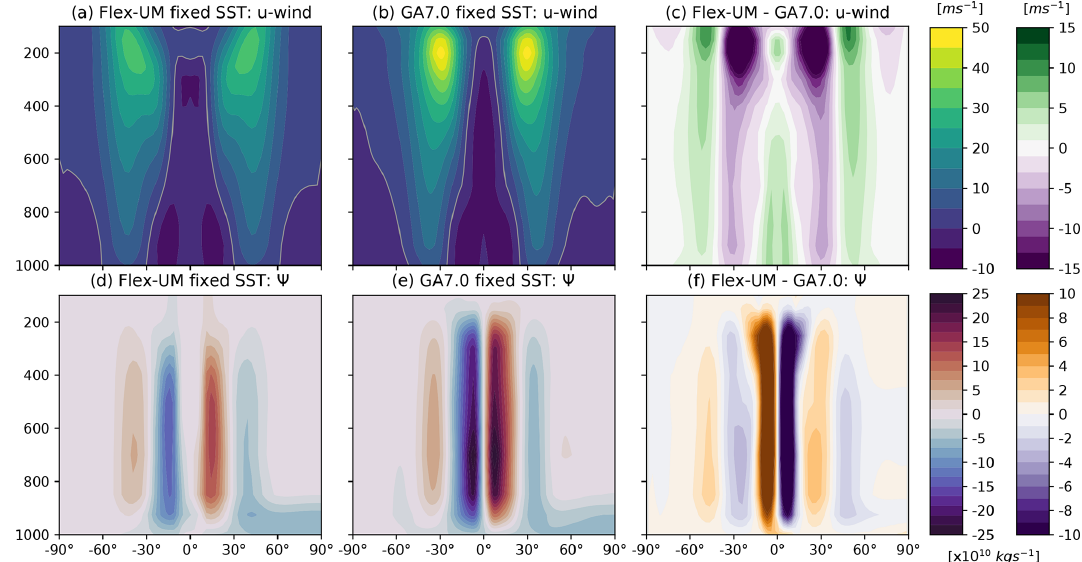
Figure 7. As in Fig. 6 but for zonal-mean zonal wind ( u in ms − 1 , a, b, c ) and mass stream function ( ψ in × 10 10 kgs − 1 , d, e, f ).